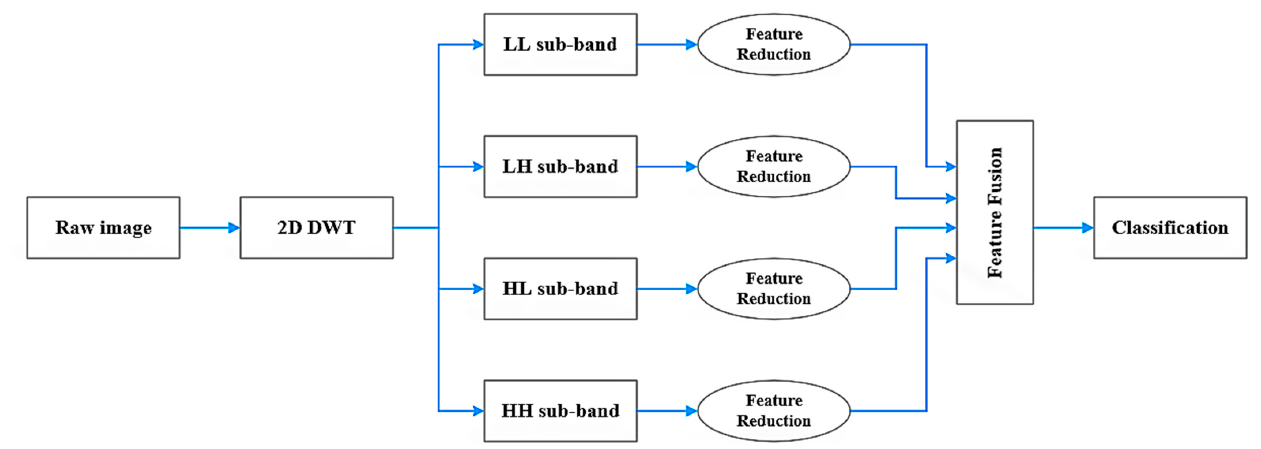
Figure 1. FastCrackNet Architecture.